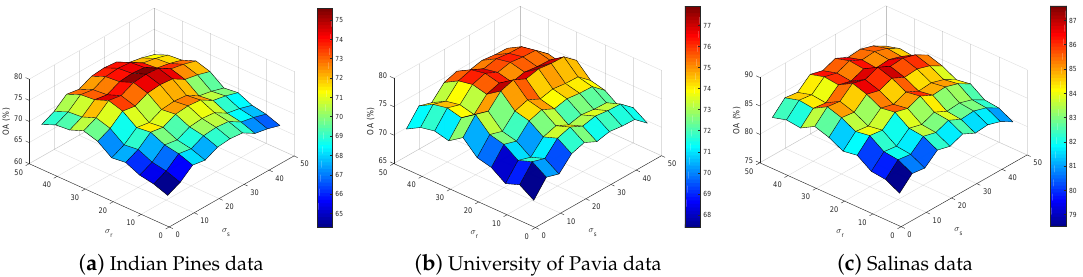
Figure 14. The impact of parameters σ s and σ r on the OA in ( a ) Indian Pines data, ( b ) University of Pavia data and ( c ) Salinas data.